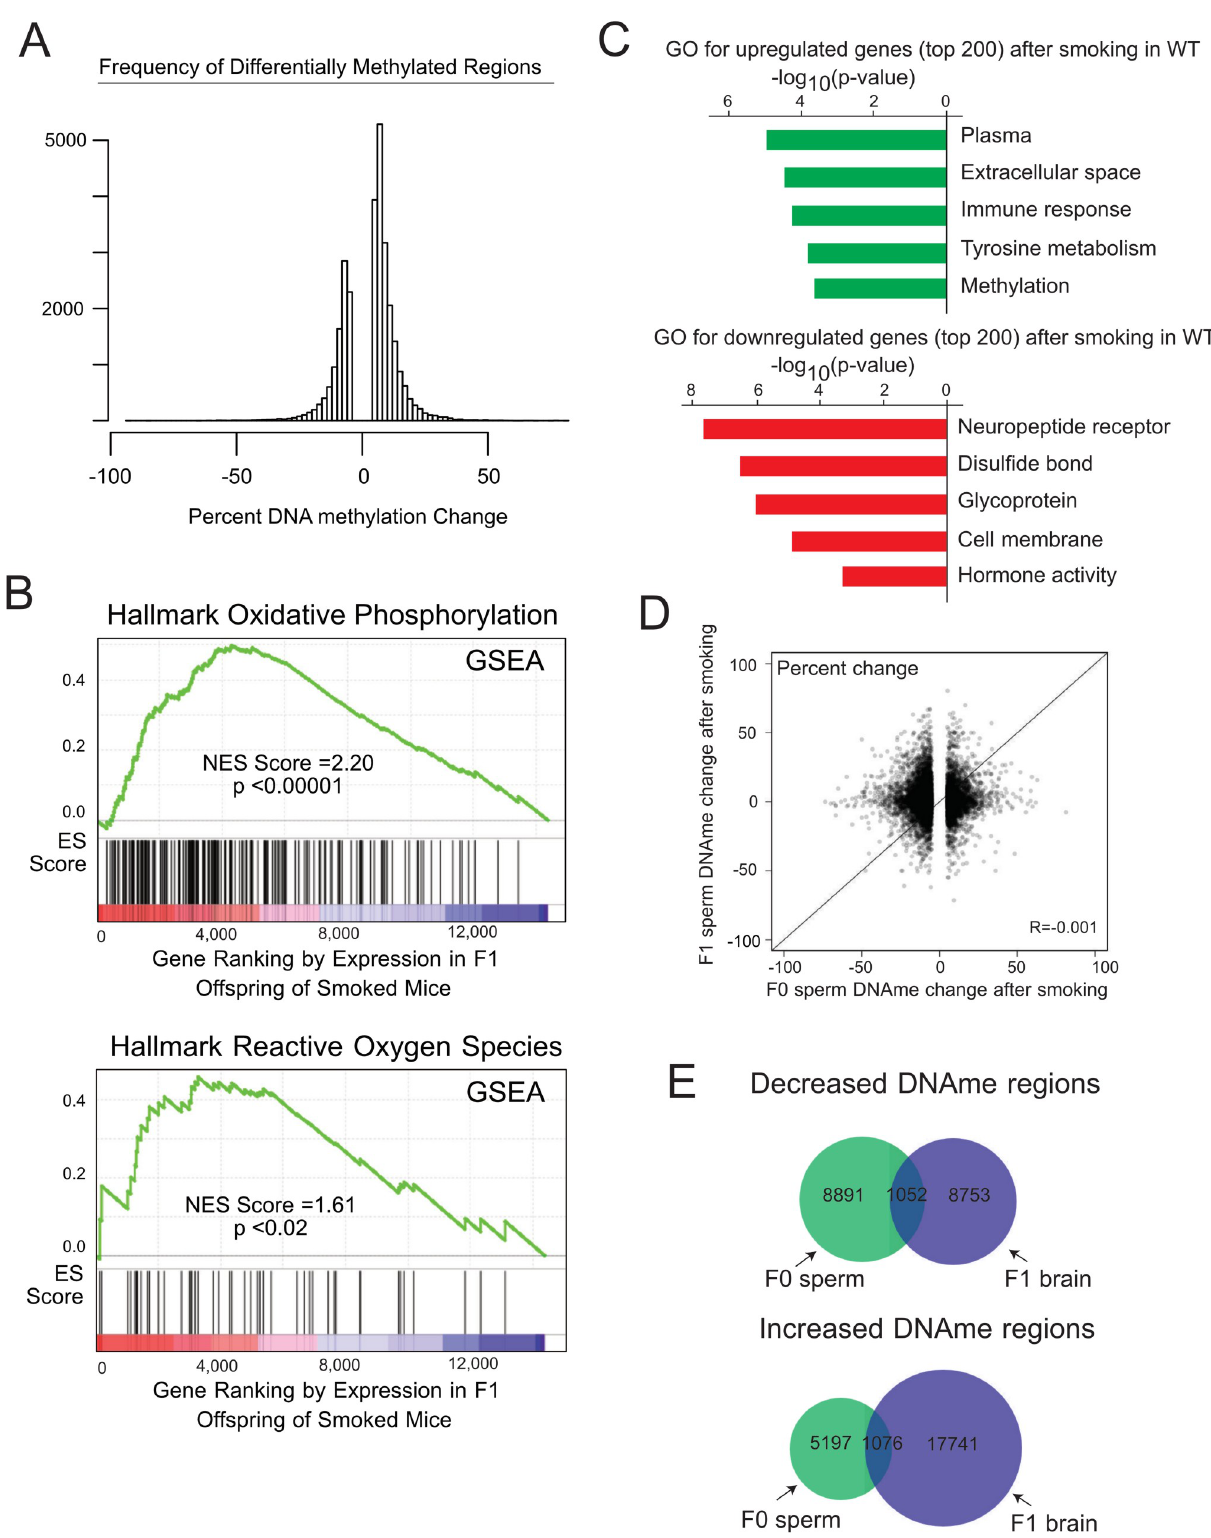
Fig 2. Cigarette smoking leads to changes in gene expression in offspring brain, but these changes do not suggest a direct DNAme inheritance model. A) Variation in F1 prefrontal cortex gene expression was significantly higher in CS-exposed animals compared with controls